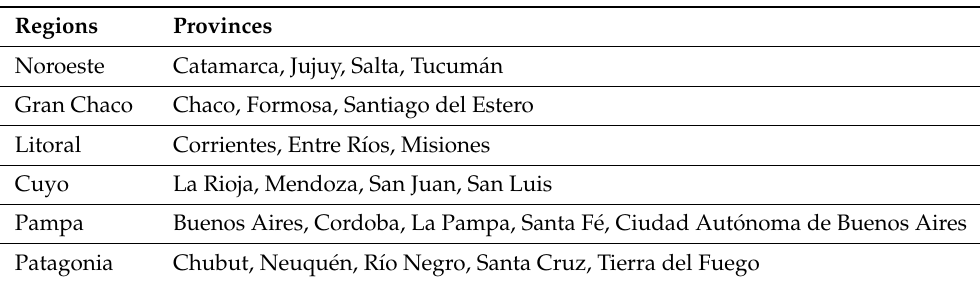
Table 2. Argentinian Regions.